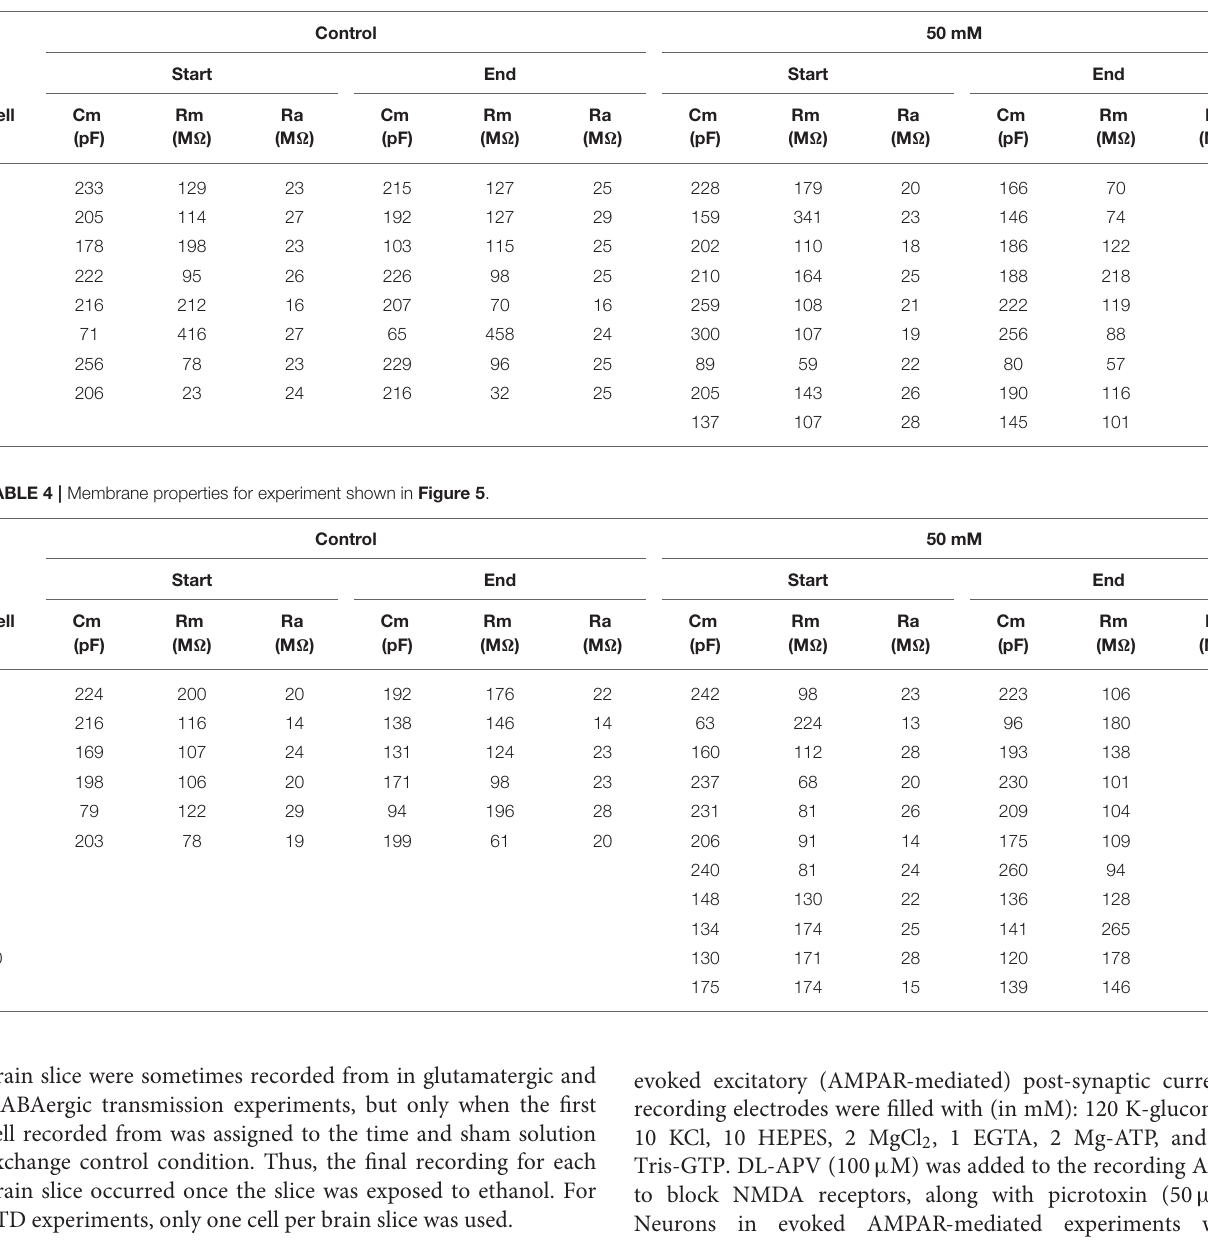
TABLE 3 | Membrane properties for experiment shown in Figure 4 .